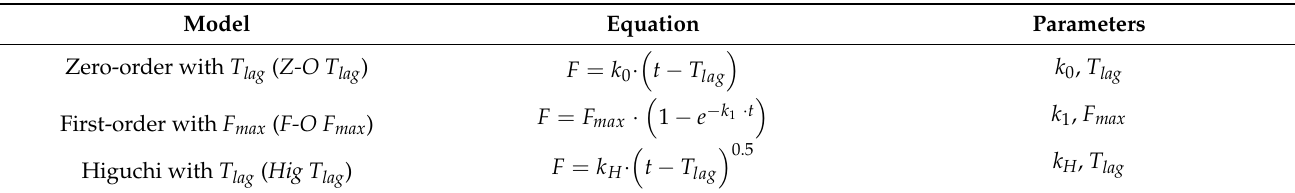
Table 1. Mathematical models used to describe the dissolution curves [27]. Model Equation